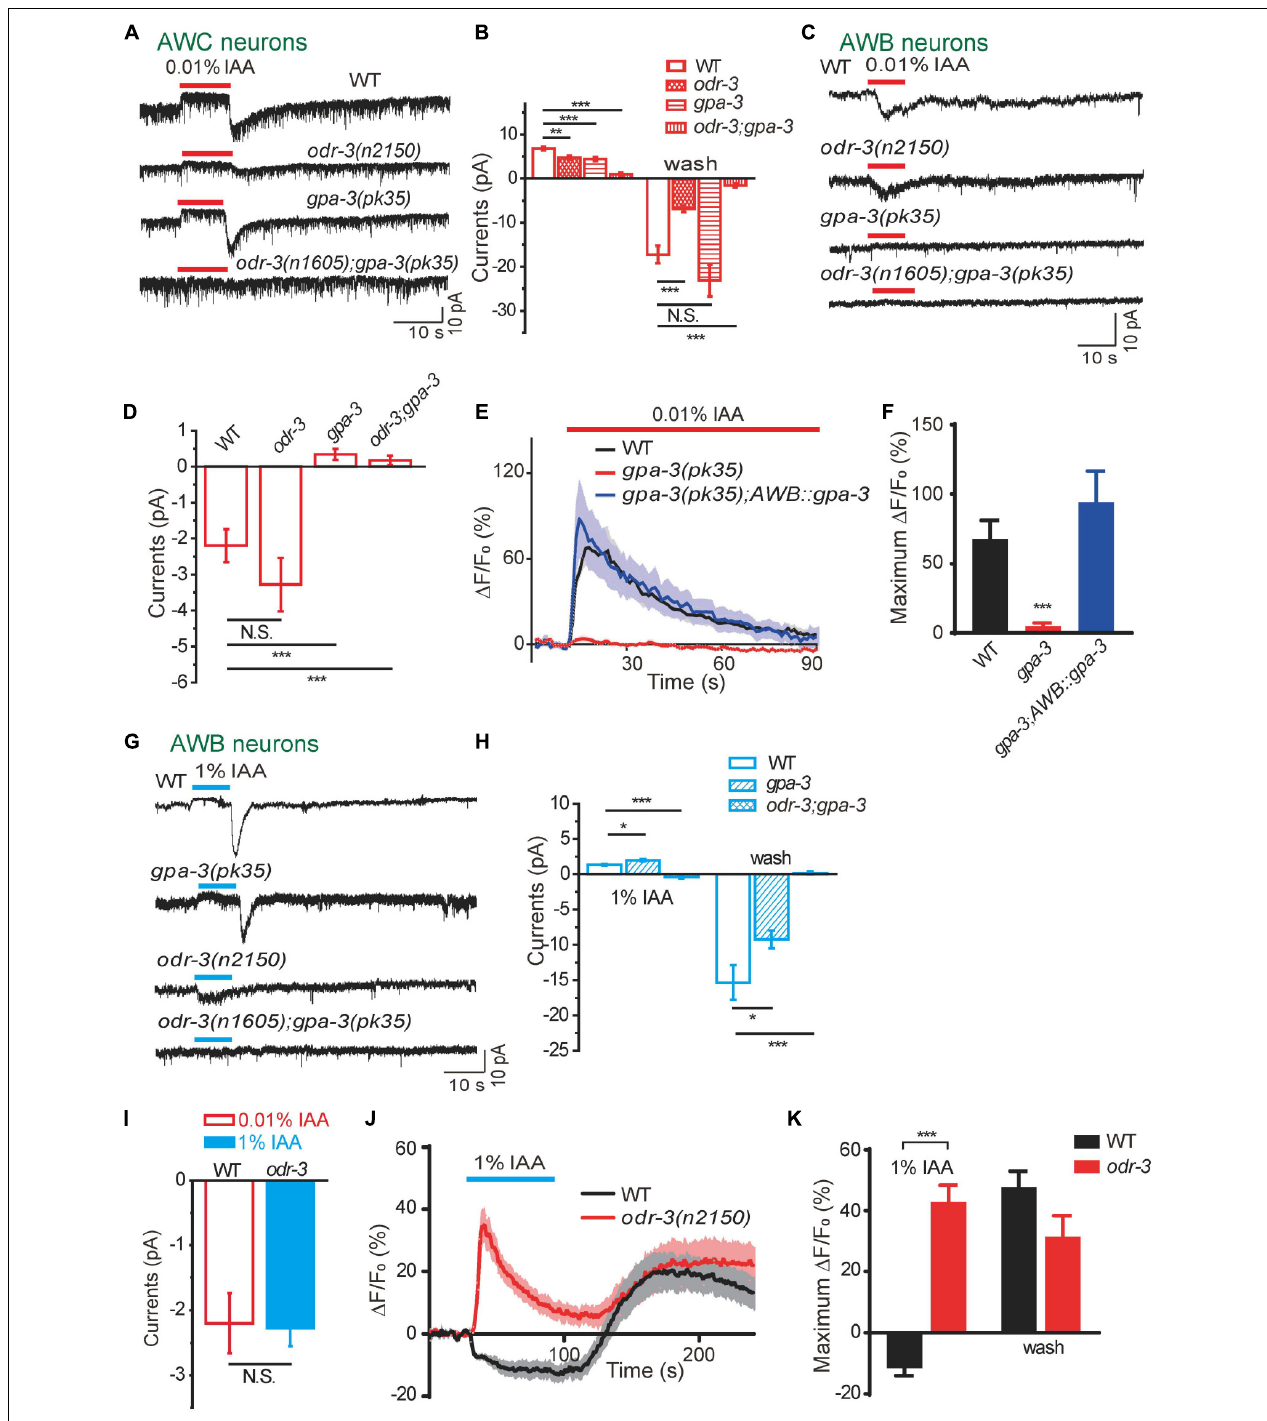
FIGURE 3 | Two G α proteins were differentially activated by different concentrations of IAA. (A,B) 0.01% IAA-induced currents from AWC neurons were mainly mediated by ODR-3. (A) Representative traces. (B) Quantification of the currents. n ≥ 6. (C,D) 0.01% IAA-induced inward currents from AWB neurons were mediated by GPA-3. (C) Representative traces. (D) Quantification of the currents. n ≥ 6. (E,F) 0.01% IAA-induced calcium increases from AWB neurons were mediated by GPA-3. (E) Representative traces. (F) Quantification of the maximum (cid:49) F/F 0 . n ≥ 7. (G–I) 1% IAA-induced outward currents from AWB neurons were mediated by ODR-3. (G) Representative traces. (H,I) Quantification of the currents. n ≥ 5. (J,K) 1% IAA-induced calcium decreases from AWB neurons were mediated by ODR-3. (J) Representative traces. (K) Quantification of the maximum (cid:49) F/F 0 . n ≥ 8. For patch-clamp recording, the cell membrane potential was voltage-clamped at –70 mV. Error bars: SEM. N.S., not significant, * P < 0.05, ** P < 0.01, *** P < 0.001.